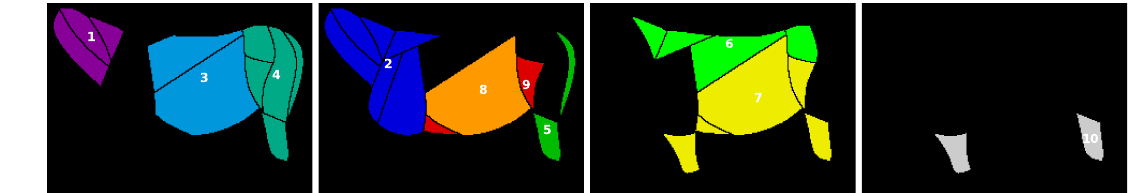
Figure 3. Visualization of a donkey D.3 , divided into groups of ROIs